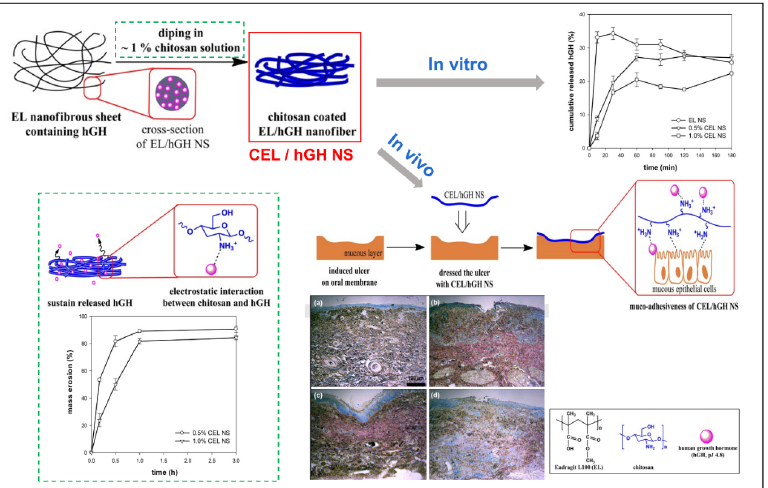
Figure 12. Schematic diagram of CEL/hGH-NS applied to the treatment of oral ulcers, reprint permission from ref. [32]. Copyright 2016, John Wiley and Sons Inc.